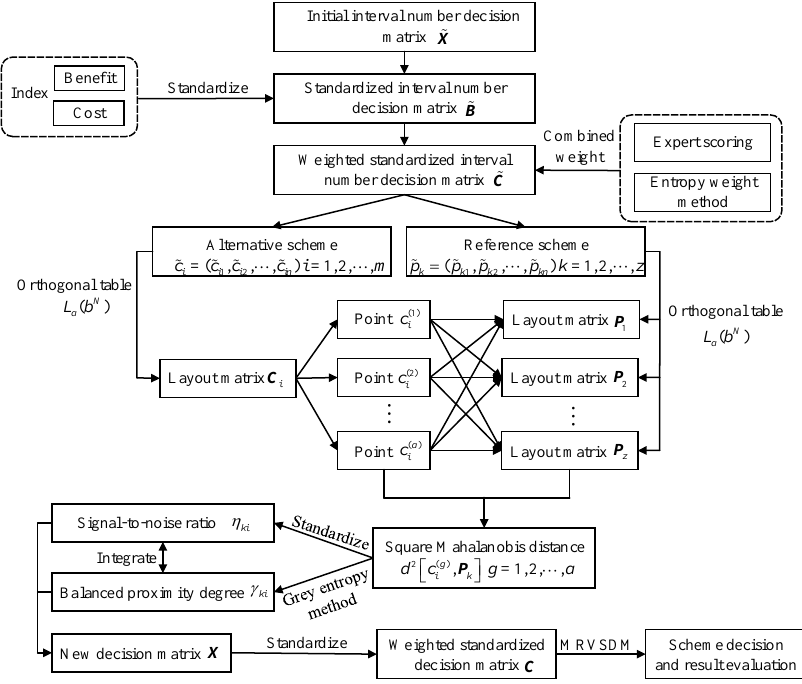
Figure 2. Diagram of decision-making in a three-dimensional real number vector space.